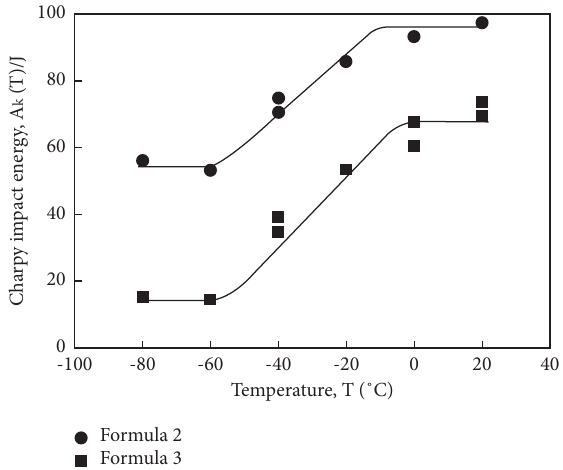
Figure 10: Charpy temperature transition curves of ultrnarrow rail